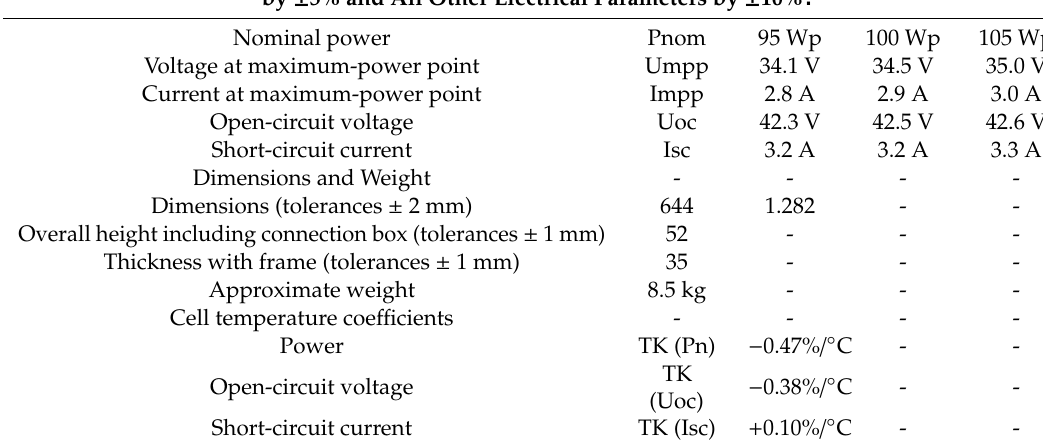
Table 1. PV module ASE-100-GT-FT by SCHOTT module specifications. The Electrical Data Apply to Standard Test Conditions (STC): Irradiance at the Module Level of 1000 W / m 2 with Spectrum AM 1.5 and a Cell Temperature of 25 ◦ C. The Rated Power May Only Vary by ± 5% and All Other Electrical Parameters by ± 10%